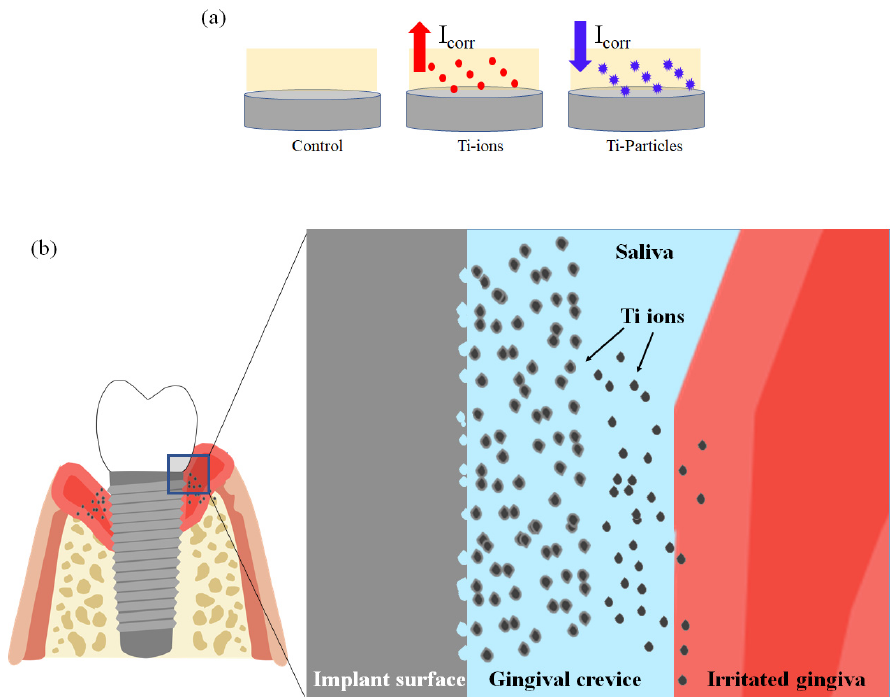
Figure 8. ( a ) The three major electrolytes used in this study and their relationship to I corr . ( b ) Schematic diagram illustrating the potential effect of Ti-ions in the vicinity of a dental implant and the surrounding tissue irritation.